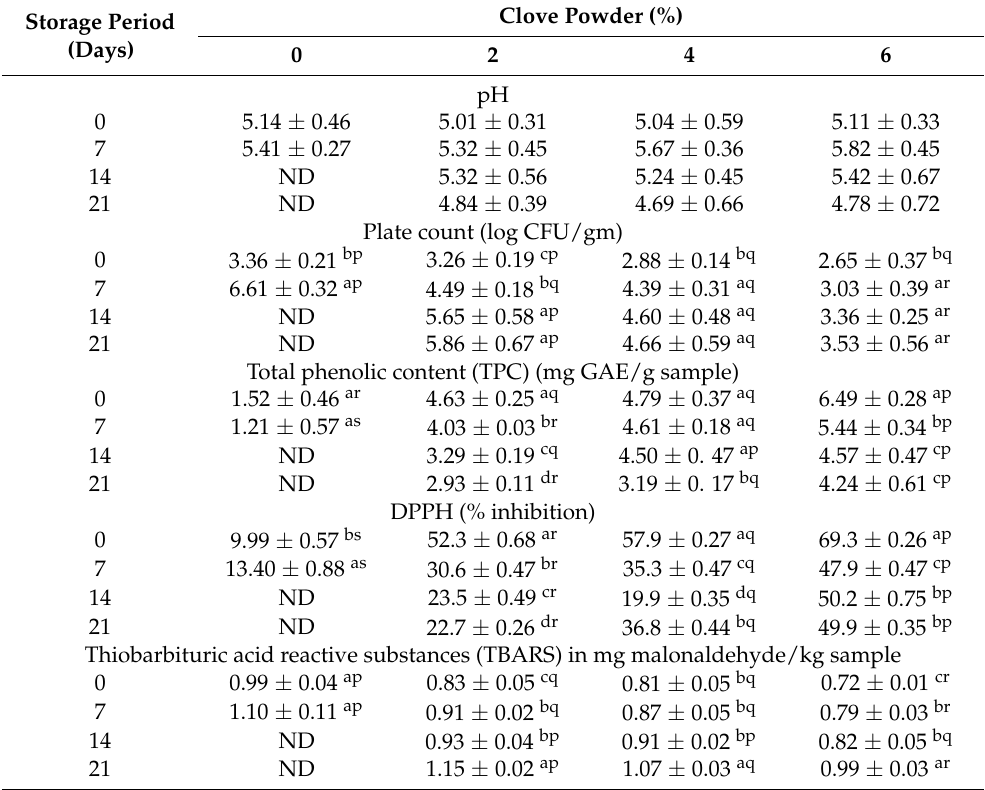
Table 3. pH, plate count, and oxidative characteristics of raw beef burger formulated with different concentrations of clove powder during storage at 4 ◦ C ( ±